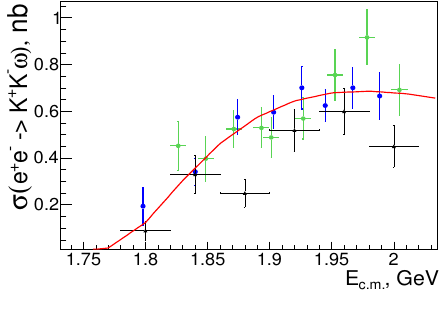
Figure 3. Cross section of the process e + e − → φ (1020) η with the BaBar data - black triangles, CMD-3 - green, blue and red points.